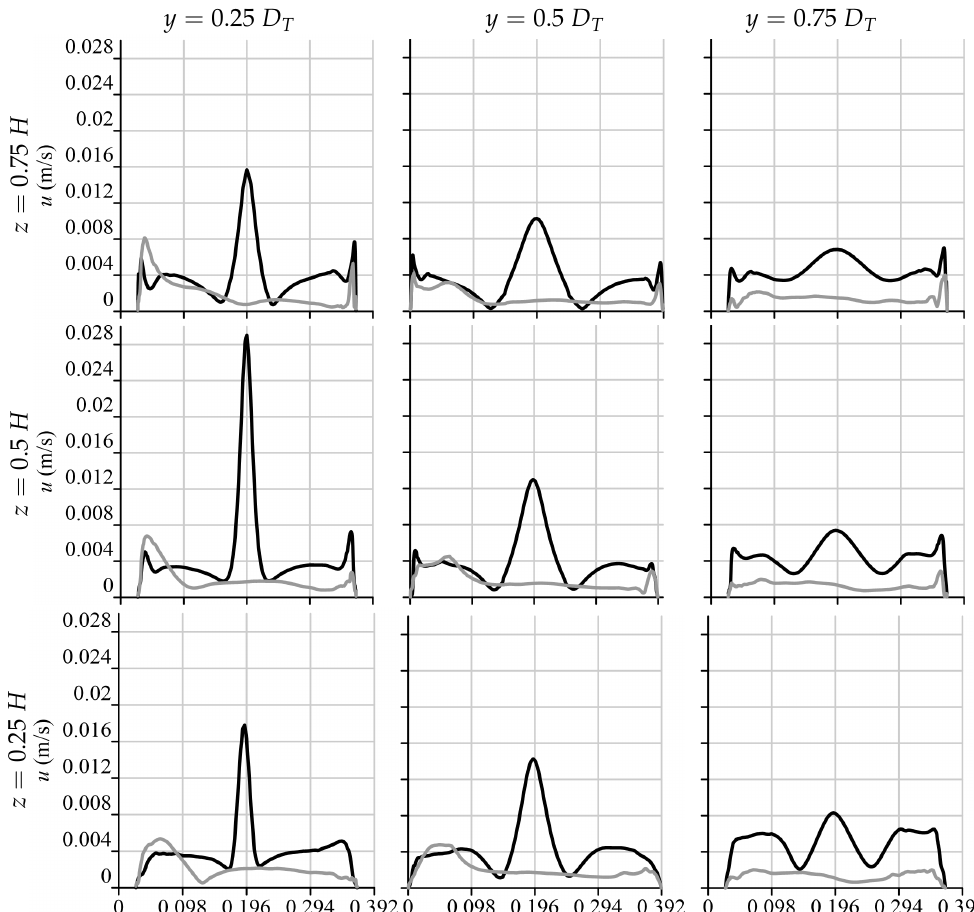
Figure 12. Velocity Profiles from: plunging jet—grey line; submerged jet—black